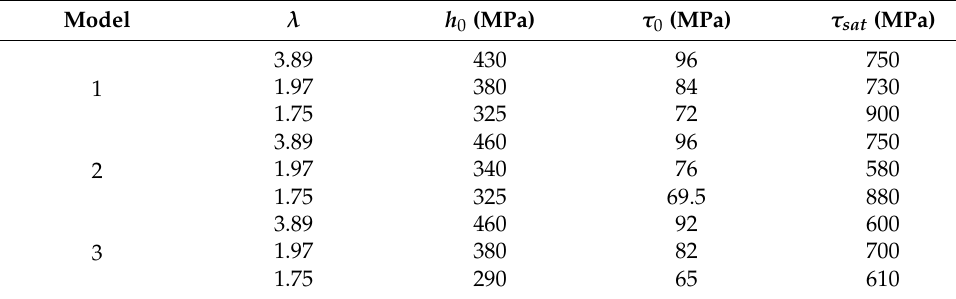
Table 2. Parameters of models with different grain